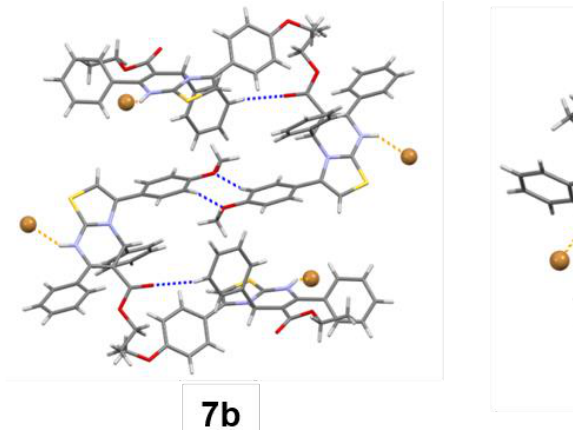
Figure 4. Hydrogen bonds in compound 4a : Inside the unit cell (left) and with other molecules outside the unit cell (right).